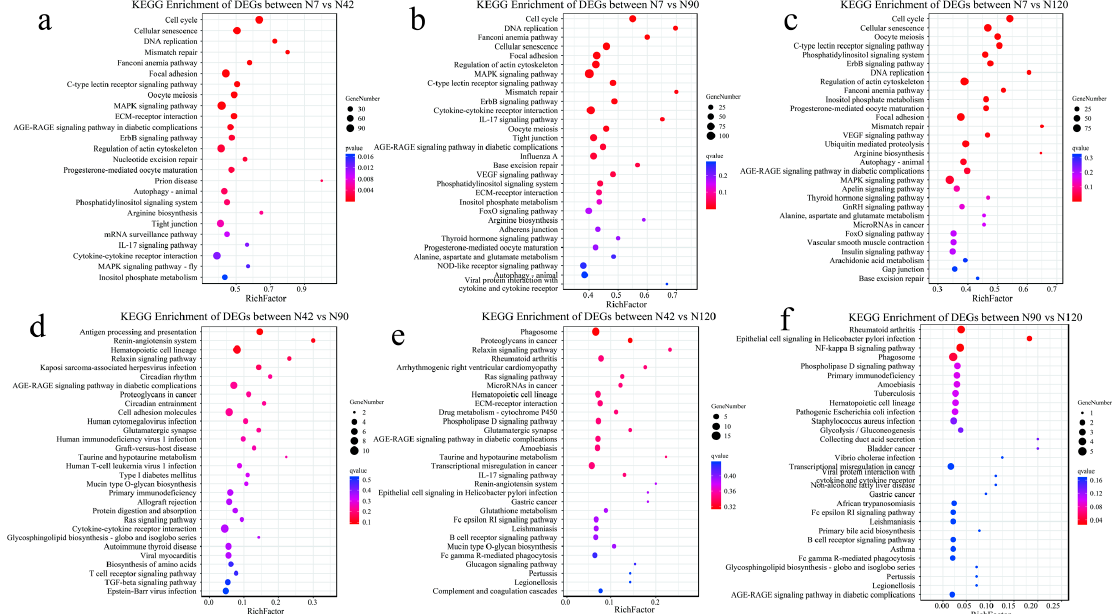
Figure 4. Dot plots of DEGs enriched by KEGG. ( a ) Dot plot of DEGs in the N7 vs. N42 comparison group; ( b ) dot plot of DEGs in the N7 vs. N90 comparison group; ( c ) dot plot of DEGs in the N7 vs. N120 comparison group; ( d ) dot plot of DEGs in the N42 vs. N90 comparison group; ( e ) dot plot of DEGs in the N42 vs. N120 comparison group; ( f ) dot plot of DEGs in the N90 vs. N120 comparison group.